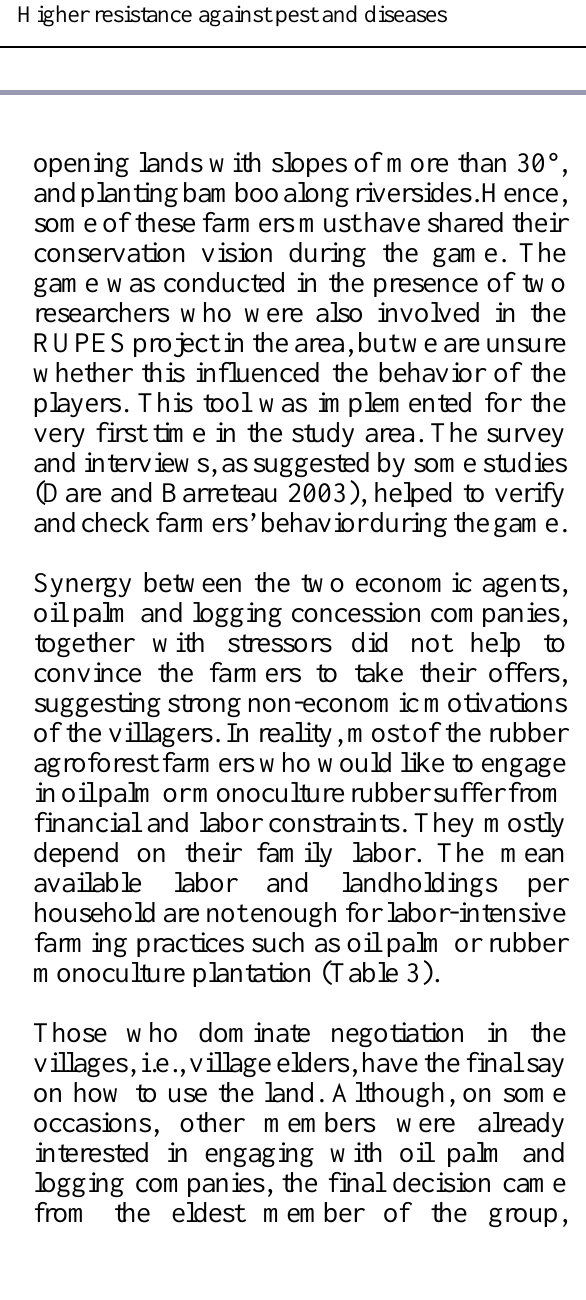
Table 6. Reasons for the land-use choice of the respondents in the study site, 2010 Jungle rubber/rubber-mixed agroforest Oil Palm Plantation Intensive rubber cultivation Easy to manage Short farming period Higher yield production Produce various crops (e.g. fruits and medicinal plants Highly-priced at the same) time commodity Well-established farming experience Lower labor